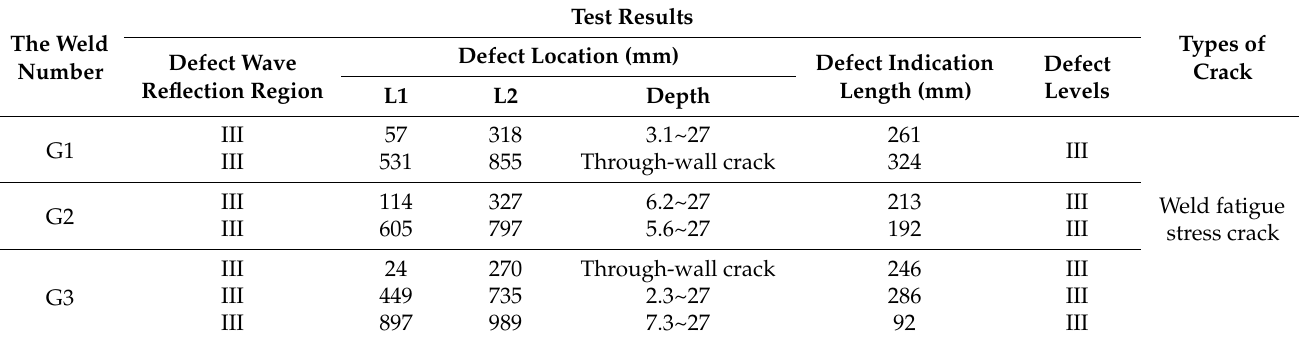
Table 3. Weld inspection of the full-scale domestic steel catenary riser in a high-stress fatigue